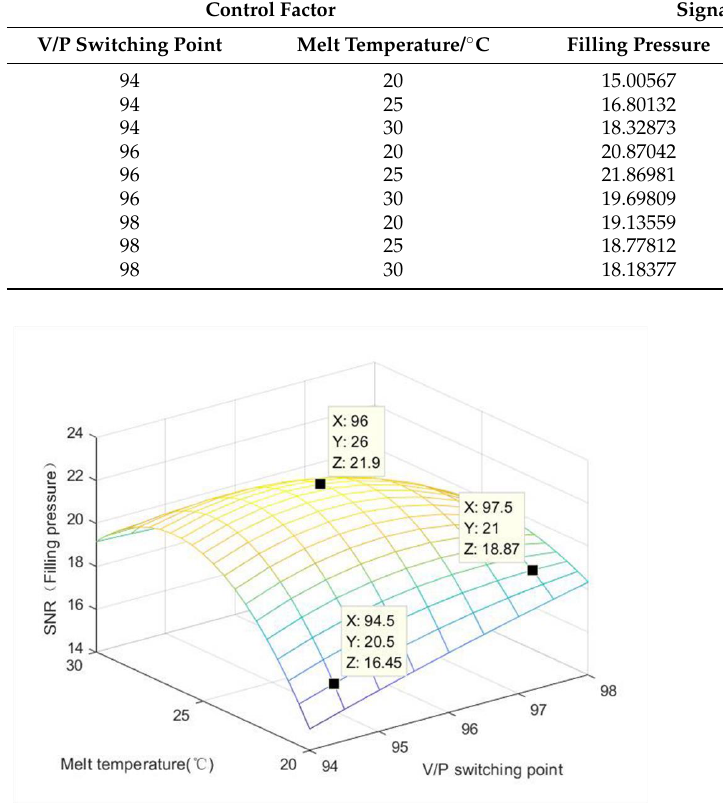
Figure 10. Effect of melt temperature and V/P switching point on the filling pressure signal.